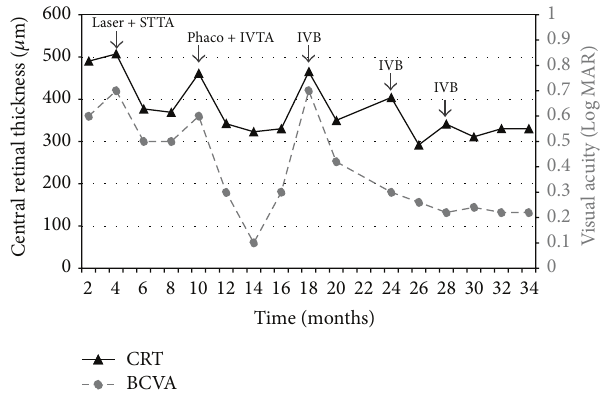
Figure 2: Visual acuity and central retinal thickness changes with treatment over time. BCVA = best corrected visual acuity; CRT = central retinal thickness; LogMAR = Logarithm of the minimum angle of resolution; Phaco = phacoemulsification; IVB = intravitreal bevacizumab; IVTA = intravitreal triamcinolone acetonide; STTA = sub-Tenon triamcinolone